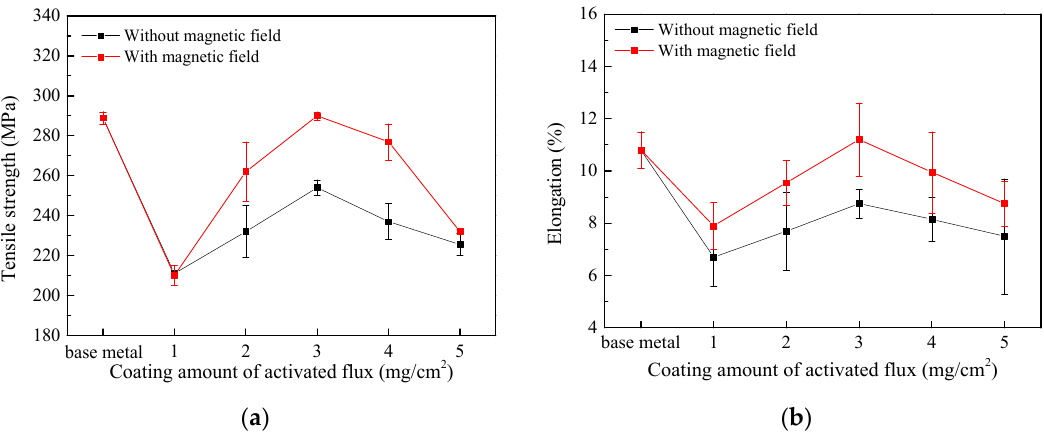
Figure 10. Hardness of weld metal and BM.